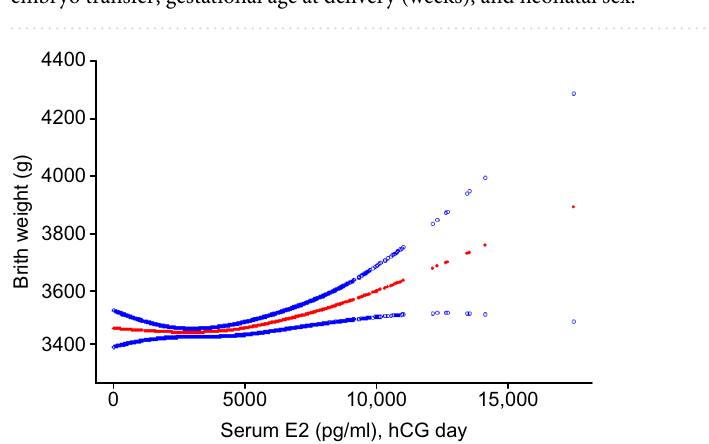
Table 5. Multivariable logistic model for all patients grouped by oestradiol level on the trigger day. Non- adjusted model: no adjustments. Adjustment model I: adjusted for maternal age (years); sterility classification; duration of infertility (years); and maternal BMI (kg/m 2 ). Adjustment model II: adjusted for maternal age (years); sterility classification; duration of infertility (years); maternal BMI (kg/m 2 ); basal FSH (mIU/mL); basal E2 (pg/mL); basal LH (mIU/mL); previous IVF attempts; ovarian stimulation protocol; total hMG dose (IU); duration of stimulation (days); number of viable embryos; number of embryos transferred; Stage of embryo transfer; gestational age at delivery (weeks); and neonatal sex.